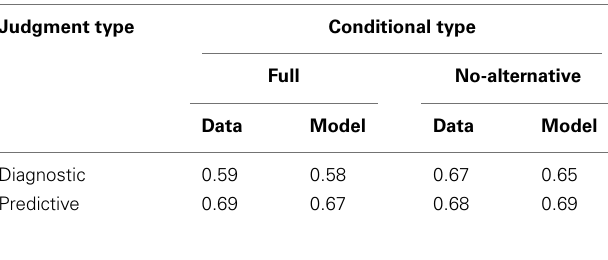
Table 2 | Model fits for predictive and diagnostic judgments with full and no-alternative